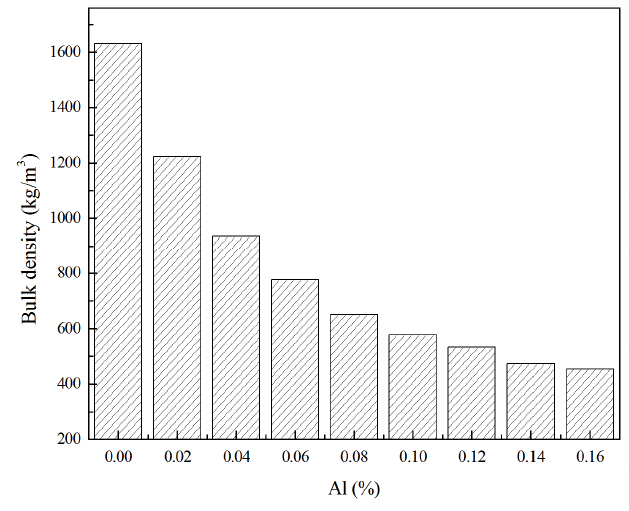
Figure 3. Bulk density as a function of Al powder content.